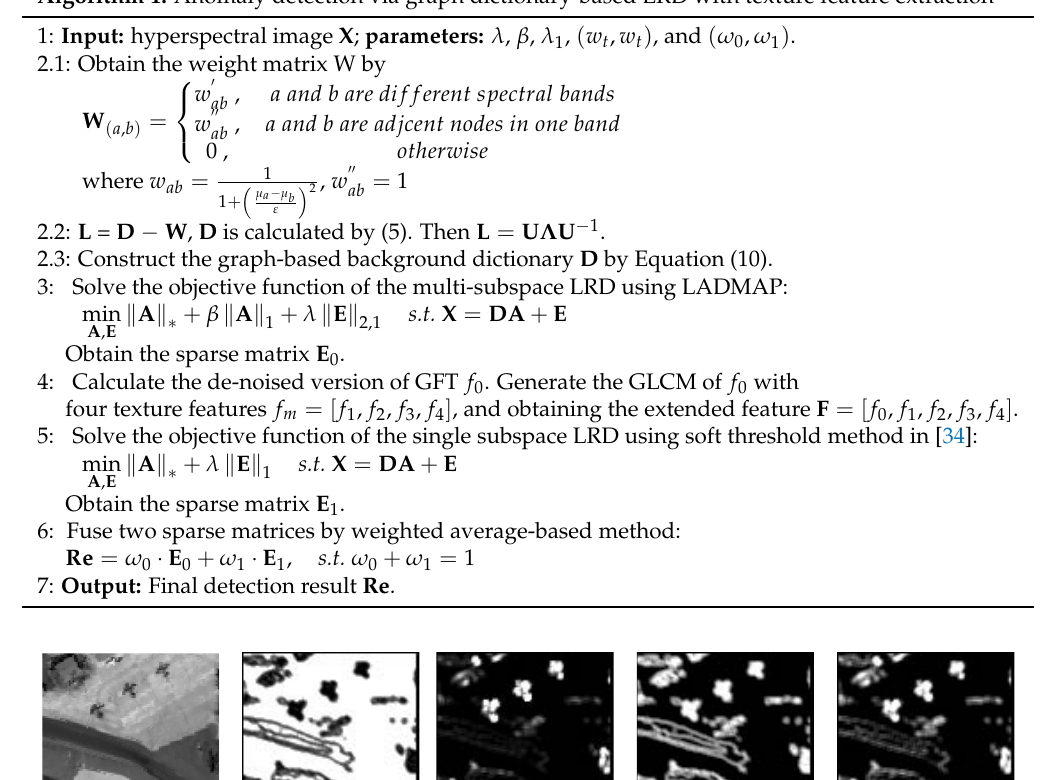
Algorithm 1. Anomaly detection via graph dictionary-based LRD with texture feature extraction